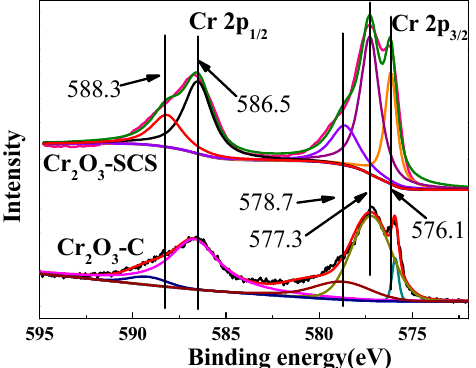
Figure 5. XPS characterization of Cr 2 O 3 -SCS and Cr 2 O 3 -C (Cr 2p 1/2 and Cr 2p 3/2 ).